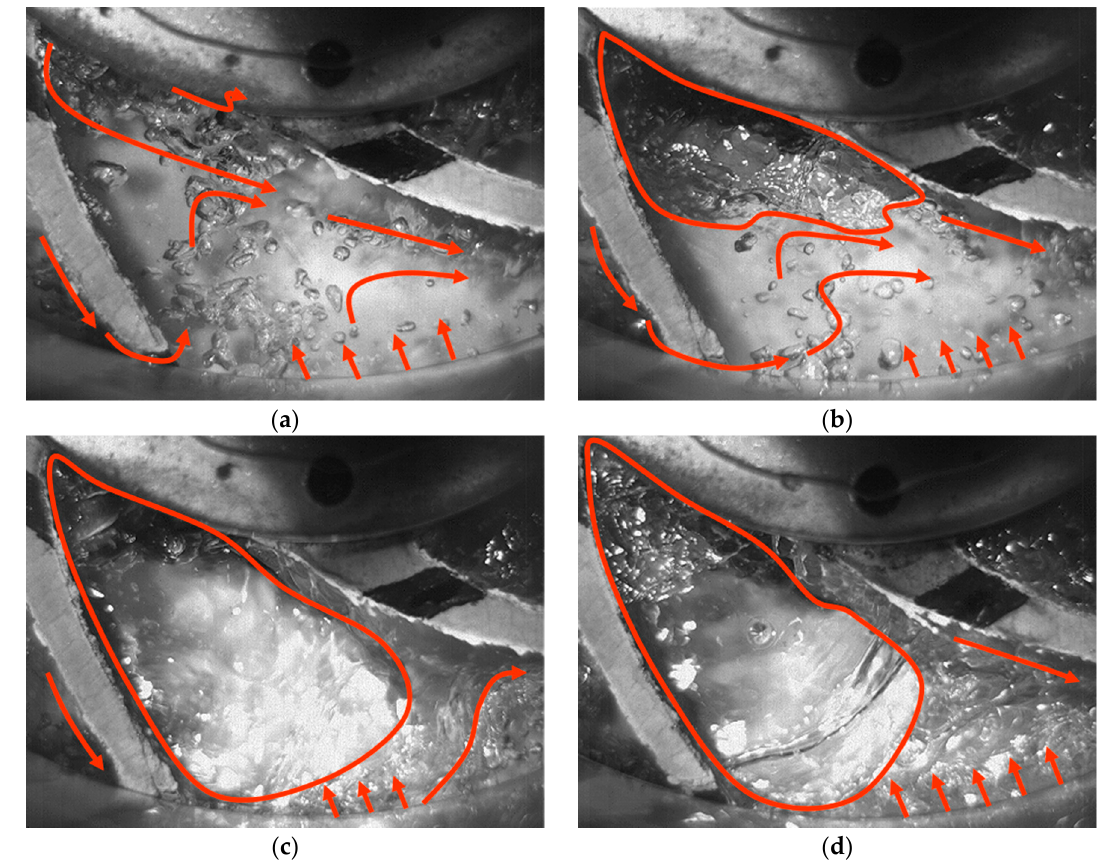
Figure 8. Impeller channel flow behavior at N = 600 rpm and Q L = 174 bpd with various gas flow rates. ( a ) λ G = 0.15%; ( b ) λ G = 0.23%; ( c ) λ G = 0.39%; ( d ) λ G = 1.05% [39].